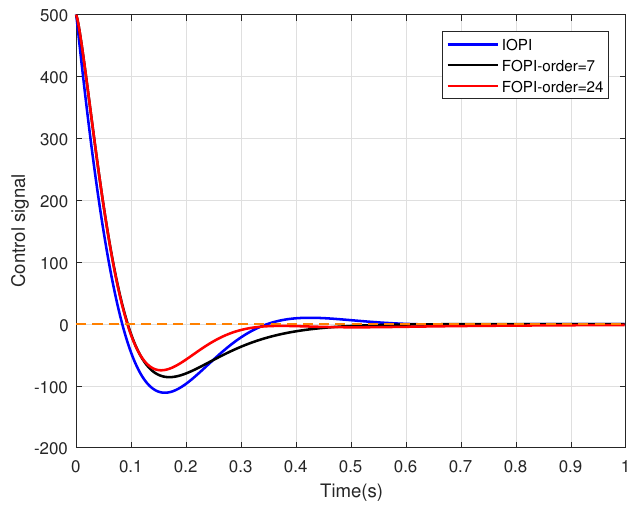
Figure 13. The controllers input signals. The unit step responses of the designed IOPI and FOPI controllers are plotted with controller gain change 0.9 to 1.1 (±10% variations from the nominal value 1), as shown in Figure 15. It can be seen that the designed high-order FOPI controller has a lower overshoot than the IOPI controller. In addition, the overshoots of the high-order FOPI controller remain almost constant under loop gain variations, which means the system is more robust to loop gain